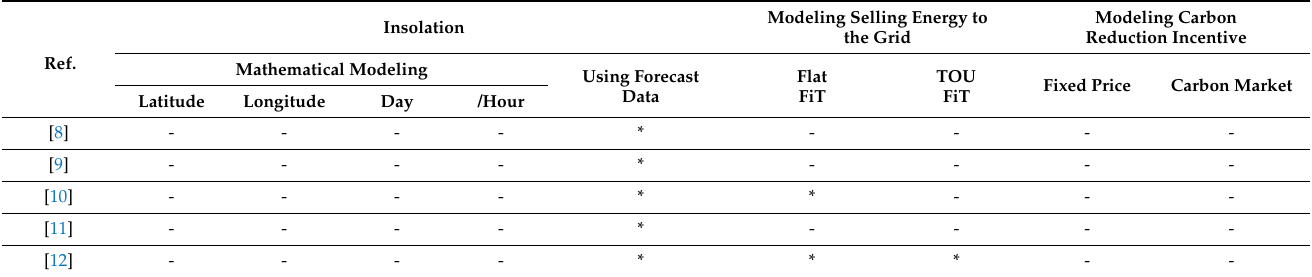
Table 1. Comparing the present paper with previous studies regarding their modeling approaches.